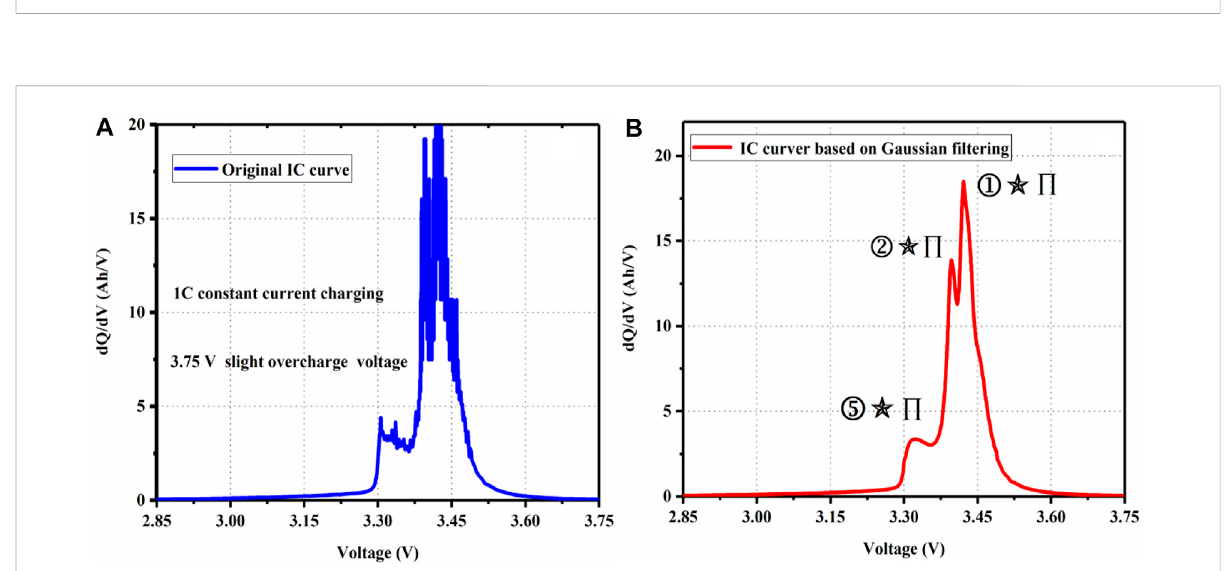
FIGURE 5 (A) Original IC curve under 3.75 slight overcharge voltage and (B) IC curve based on Gaussian fi ltering under 3.75 slight overcharge